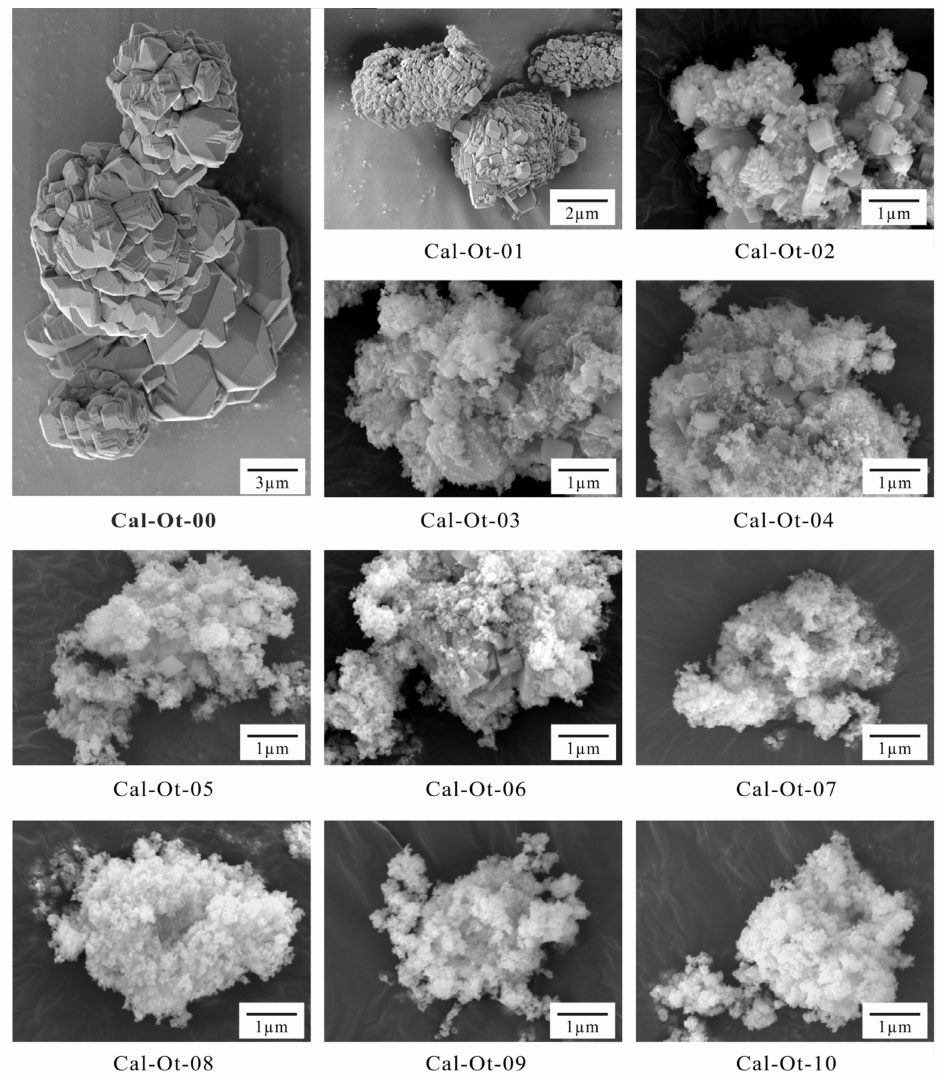
Figure 4. SEM images of the (Ca 1 − x Cd x )CO 3 solid solutions after dissolution in the CO 2 -saturated water for 270